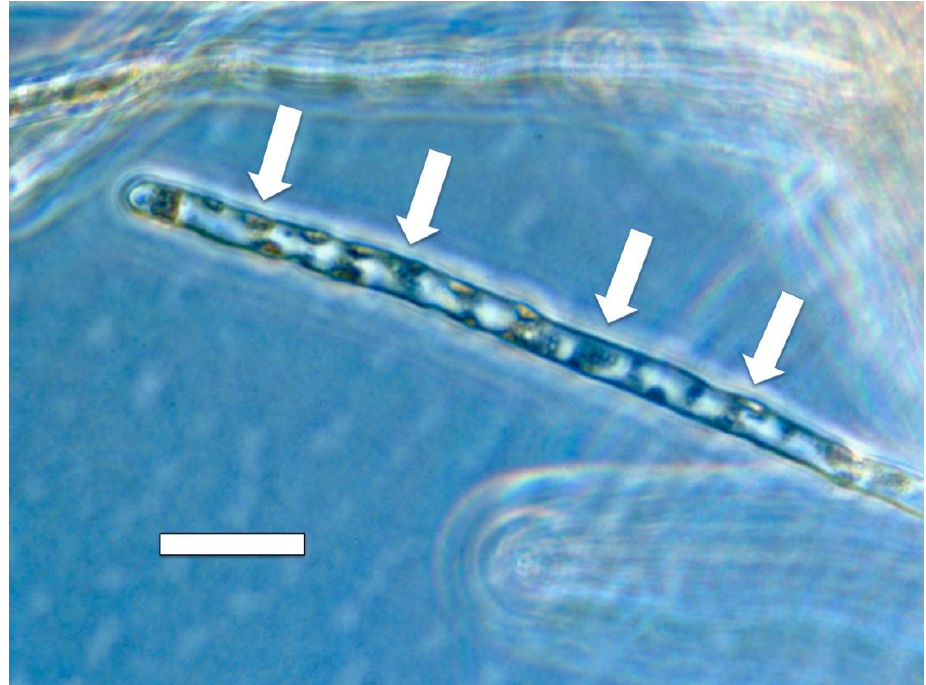
Figure 14. Root hair of Cynodon dactylon showing patches (arrows) of the bacterium Bosea thiooxidans (originally isolated from Fallopia japonica ) pressed into the lateral walls of the root hair after each growth spurt of the hair (bar = 30 µm).